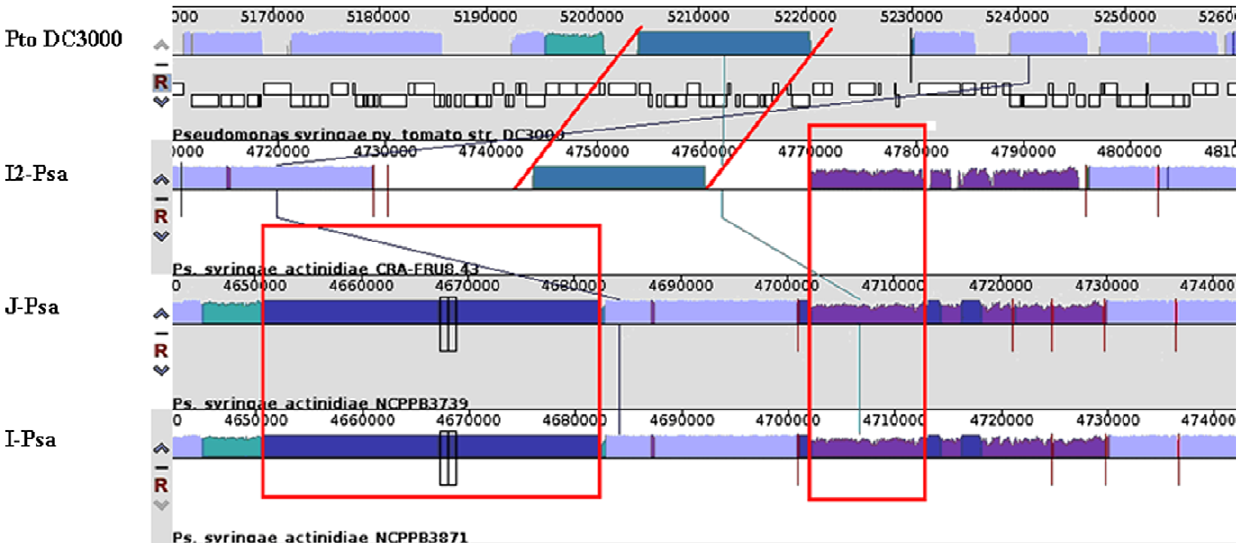
Figure 3. Representative part of the genome alignment between Psa strains and Pto DC3000 showing some variable regions. The violet segments (on the right) point out the variable region 3, present in all three Psa strains but not in Pto DC3000; the deep blue (on the left) segments point out the variable region 2, present in J- Psa and I- Psa but absent in I2- Psa and Pto DC3000. The blue segments indicate another variable region present in Pto DC3000 and I2- Psa but not in J- Psa and I2- Psa. The figure shows also some others shorter regions (i.e. light green segments)